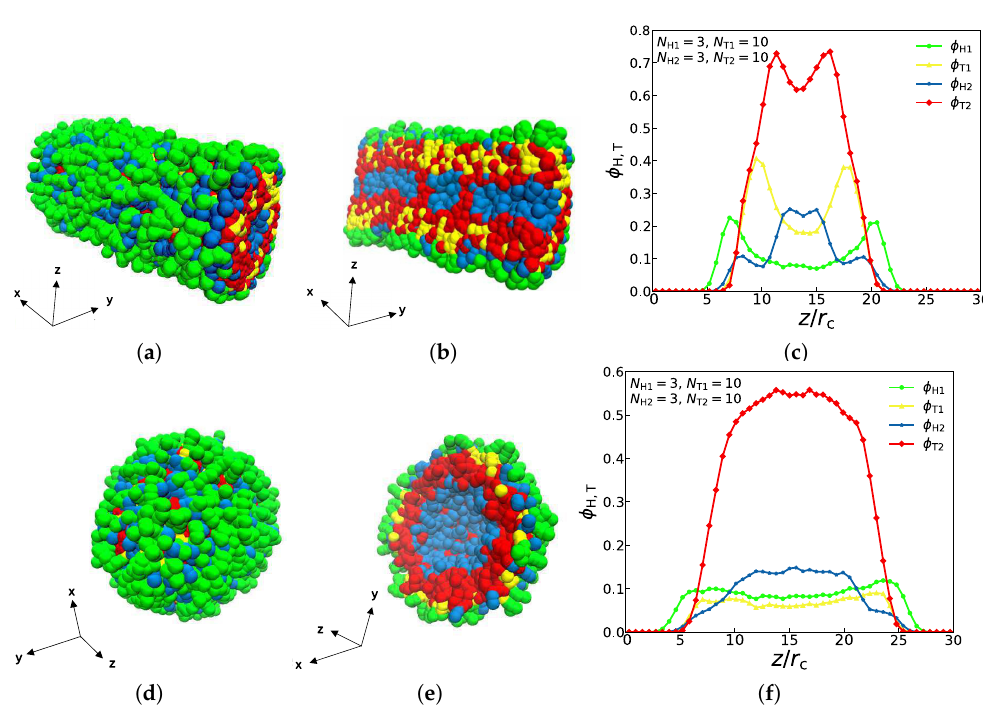
Figure 4. Typical asymmetric tube and vesicle. ( a – c ) asymmetric tube with N H1 = 3, N T1 = 5, N H2 = 3, N T2 = 5, ( d – f ) asymmetric vesicle with N H1 = 3, N T1 = 2, N H2 = 3, N T2 = 6. The density profiles of head and tail particles are shown along the z axes on the